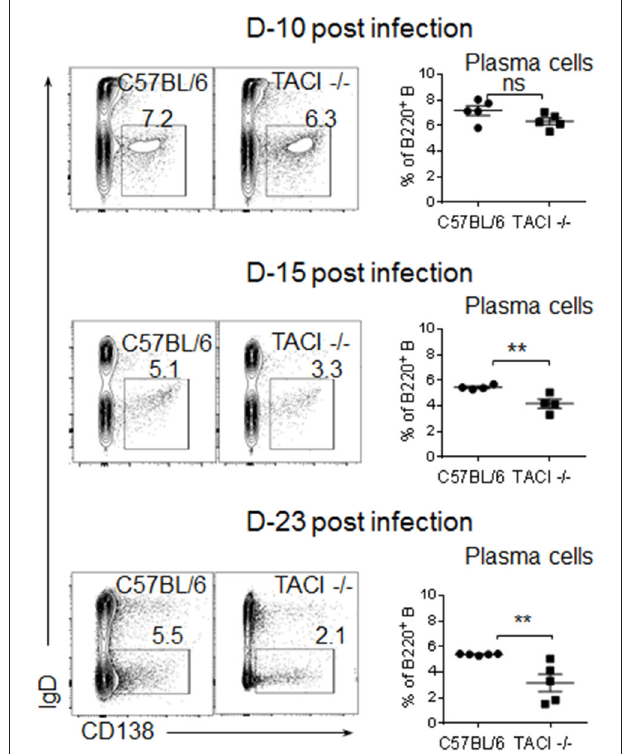
FIGURE 4 | Development of PC in infected TACI -/- mice. TACI -/- and C57BL/6 mice were infected (i.p.) with 1 × 10 6 P. yoelii (Py 17XNL strain) parasites. Representative dot blots of splenic B220 gated IgD-CD138 + plasma cells on indicated time points are shown. Mean frequencies of PC as percentages of B cells are plotted for each time point. Each data point represents a mouse. Unpaired Student’s t -test is used for statistical evaluation. Results are expressed as mean ± SEM ( n = 5) from one representative experiment out of two with similar results. ** p < 0.01 indicates TACI -/- vs. C57BL/6 mice. ns, not